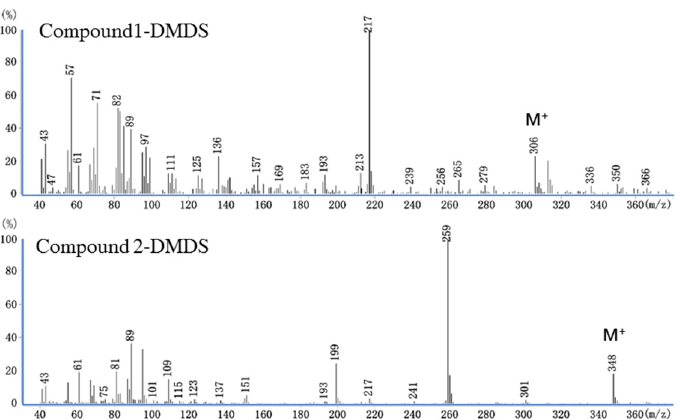
Figure 4. Gas chromatography–mass spectrometry (GC–MS) analysis of pooled Archips strojny female crude pheromone gland extract (n = 8) treated with dimethyl disulfide (DMDS). ( A ) Mass spectrum of Compound 1-DMDS adduct, ( B ) mass spectrum of Compound 2-DMDS adduct. Table 2. Gas chromatography–mass spectrometry (GC–MS) analysis of natural pheromone extract of Archips strojny and synthetic ( E ) and (Z) configuration standards on different GC columns (RT: retention time; KI: Kovats